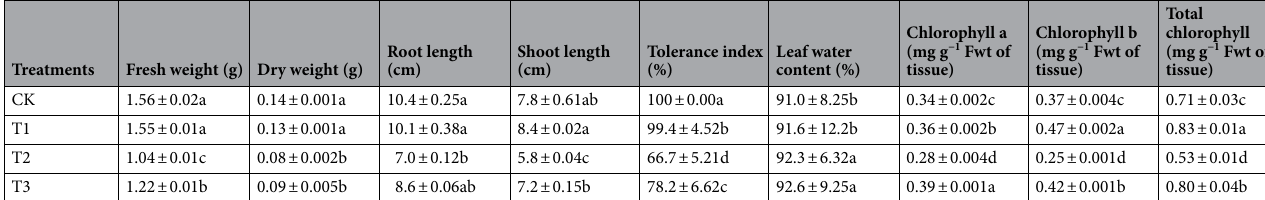
Table 1. Effect of an exogenous hemin (0.5 mM) on biomass, height, tolerance index, leaf water content and chlorophyll (Chl a, Chl b and Total Chl) content in seedlings of V. radiata treated with CdCl 2 (50 µM) for a period of 96 h. Values are mean ± SE (n = 3) from three replicates for each treatments. Values marked with different letters shows significant differences (p ≤ 0.05) within treatment. Here CK, T1, T2 and T3